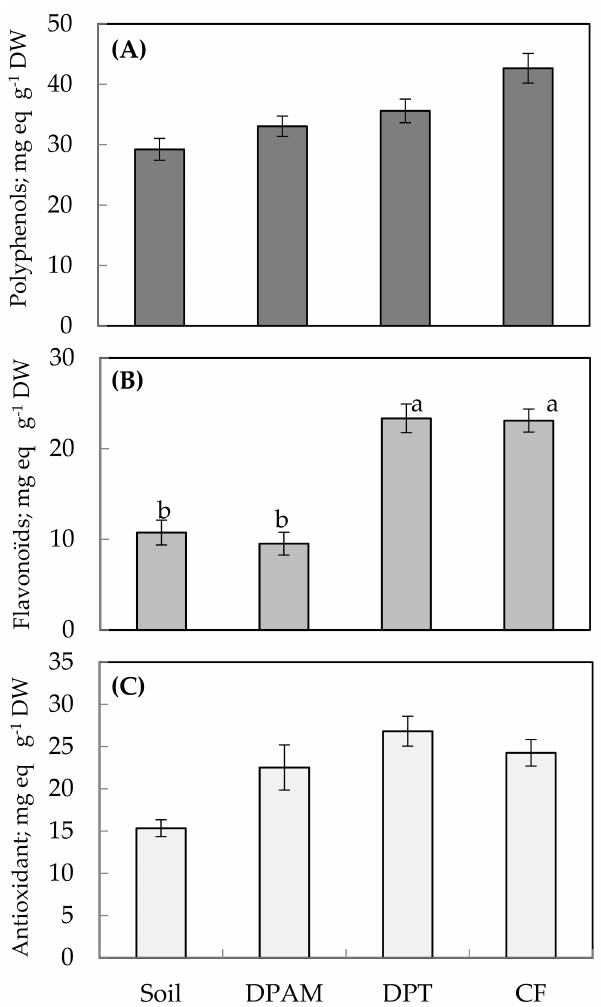
Figure 4. Phytochemical composition and antioxidant activity of extract of melon fruit grown on a different substrate. DPAM: compost of date palm residues and animal manure; DPT: compost of date palm trunk; CF: coconut fiber, compared with soil substrate. ( A ): Total polyphenols content. ( B ): Total flavonoid content. ( C ): Antioxidant activities. Results expressed as gallic acid or catechin equivalents (mg Equivalent g − 1 DW) are the mean of triplicate determinations ± S.D. Numbers followed by a different letter within a panel are significantly different at p ≤ 0.05, according to LSD